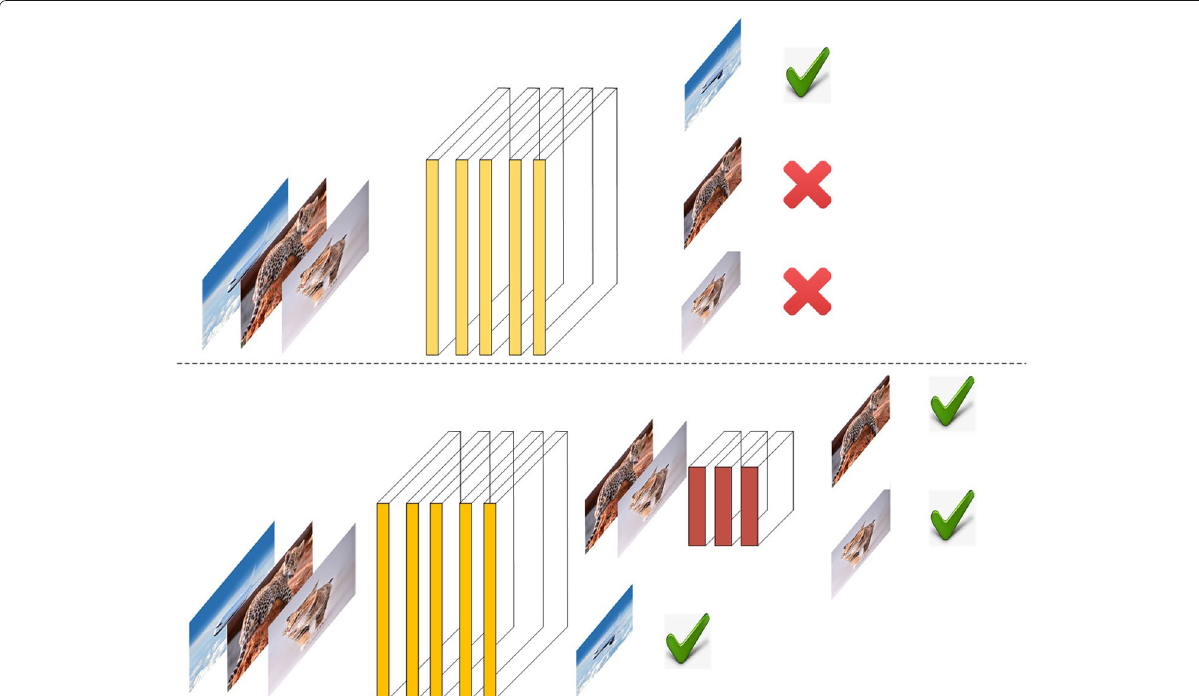
Fig. 1 The difference between common CNN (top) and the Tree-CNN (bottom). The common CNN is not sensitive to similar categories when